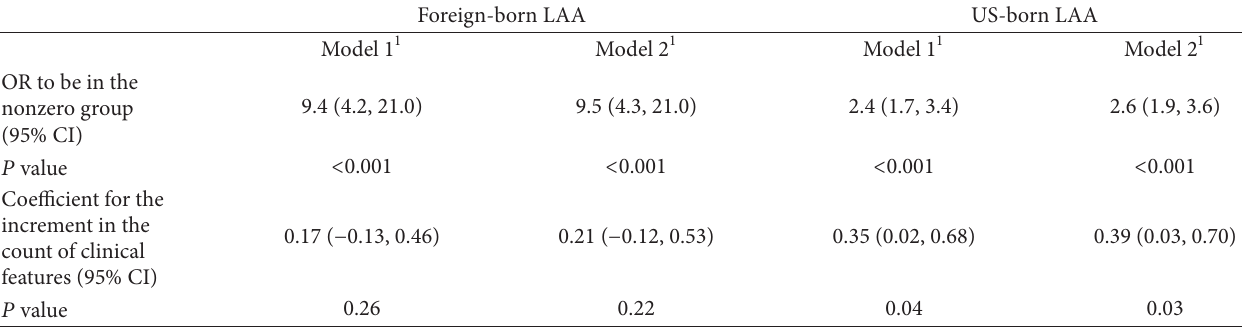
T 3: Estimates for male-female ratios from the zero-in�ated poisson regression among drinkers. Data from NLAAS,